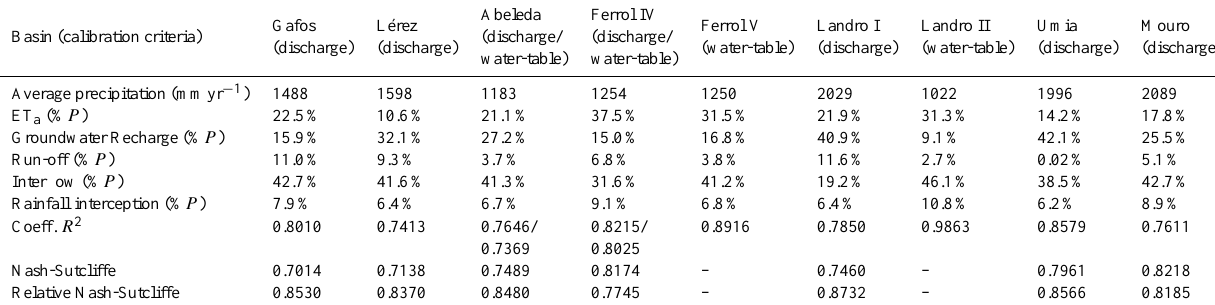
Table 2. Results and evaluation of the hydrologic goodness of fit in the studied catchments.